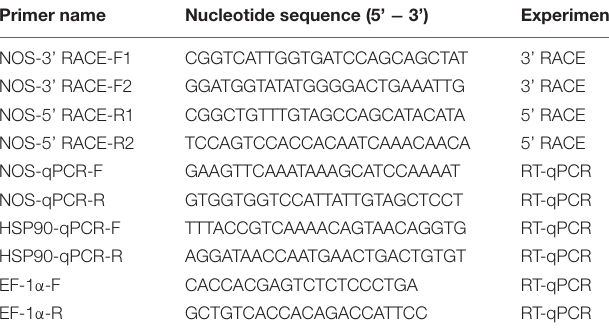
TABLE 1 | Primers used for gene cloning and expression